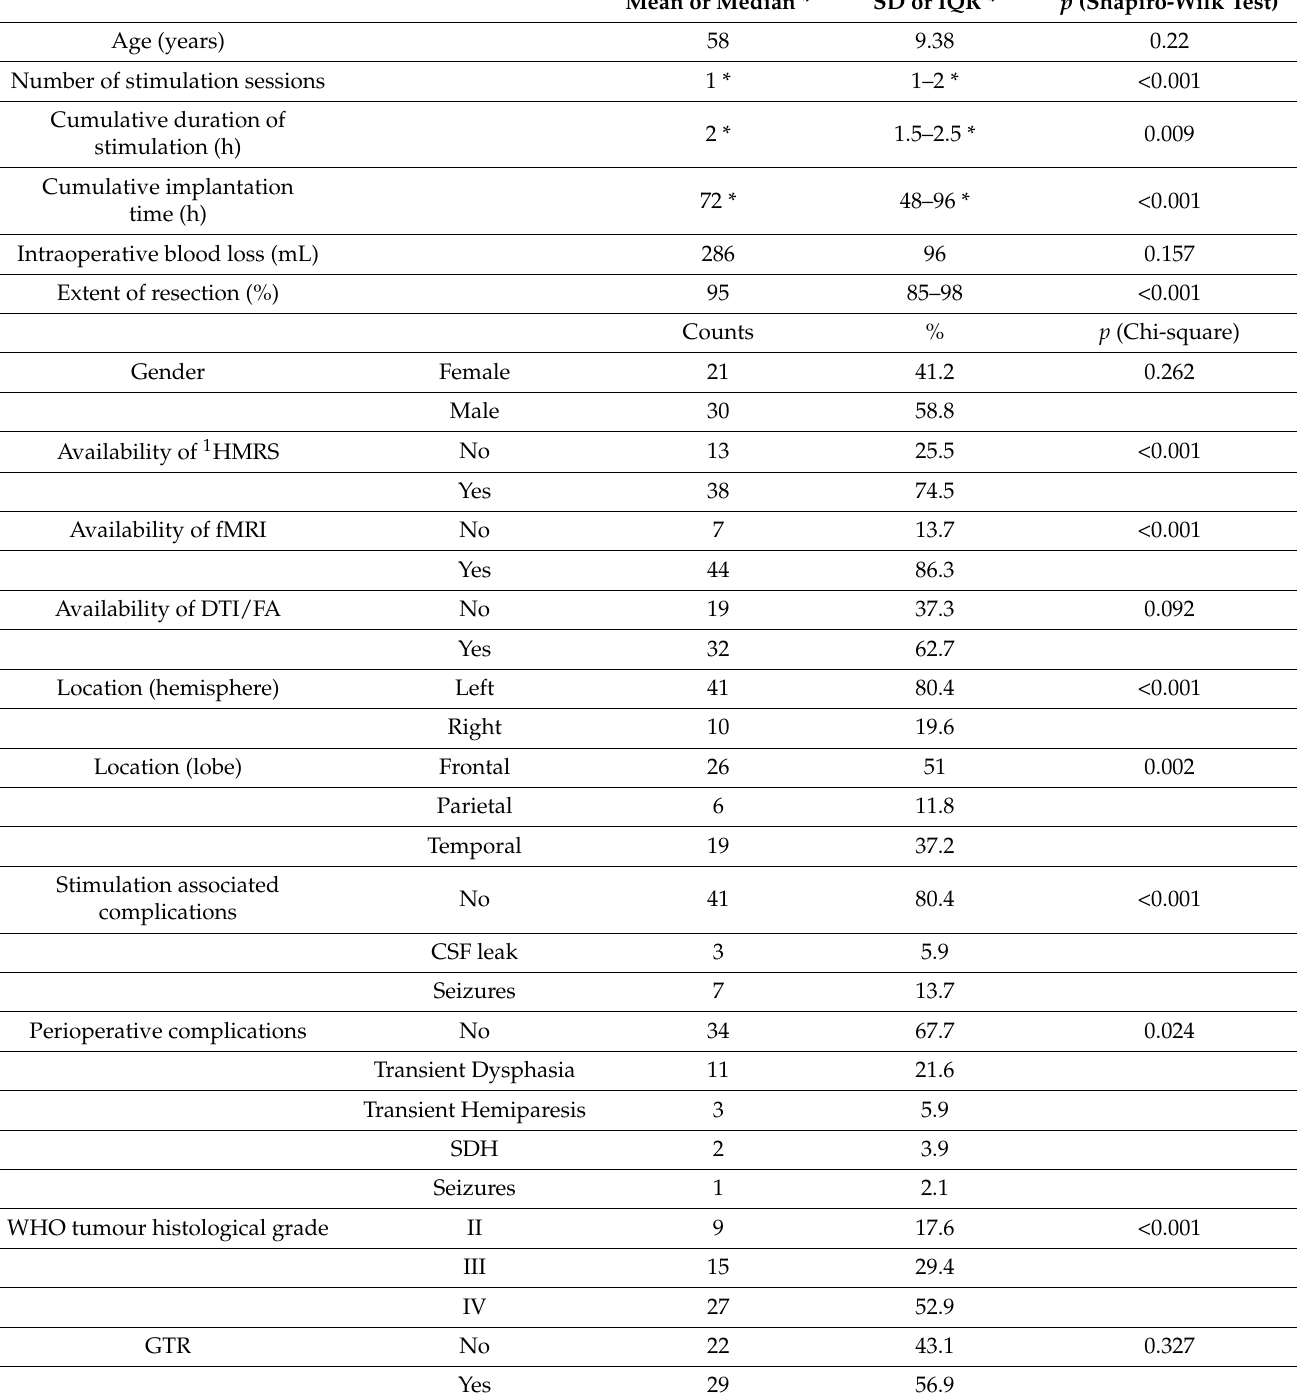
Table 1. This is a summary of basic characteristics of our study sample (N =